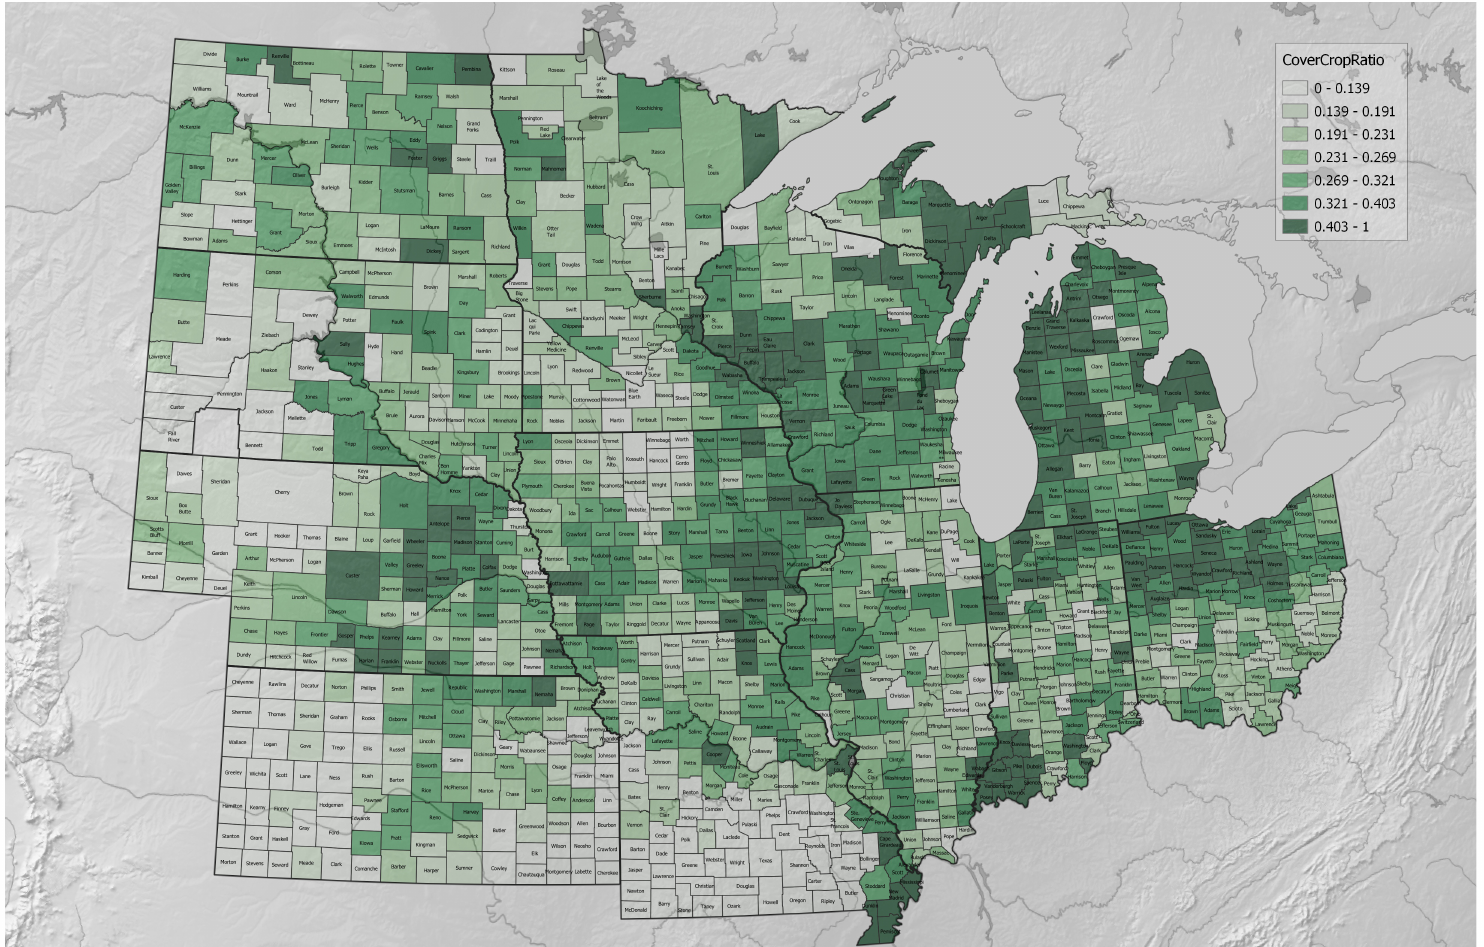
Figure A5. Fraction of farms planting cover crops, by county, 2017. Values were all rescaled through dividing by the largest value present for any of the counties included here (0.333 in Keweenaw County, Michigan), as this transformation was applied to the variable data as they were placed into the index expression. Methods for CoverCropsRatio are described in the article main text and Supplementary Materials. USDA 2017 Census of Agriculture data [52] were